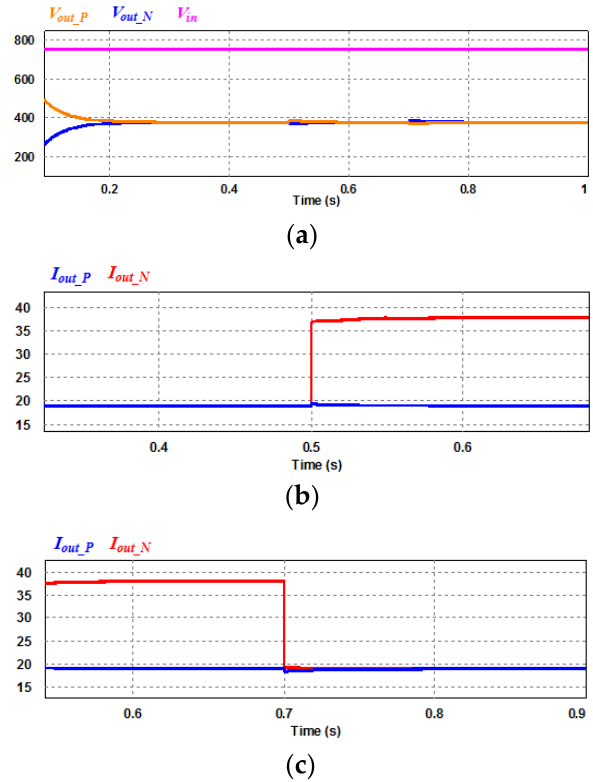
Figure 8. Simulation waveforms under load variation conditions: ( a ) Waveforms of input and output DC bus voltages during the whole simulation time; ( b ) waveforms of load currents at unbalanced load (increased load), ( c ) waveforms of load currents at unbalanced load (decreased load). Figure 9a,b are respectively waveforms of I L , which is the total inductor current of the CI, and Figure 9c,d are respectively current waveforms under the balanced load condition and unbalanced load condition. As a result of the simulation, the validity of constant voltage control of the bipolar voltage buses with the proposed VB is verified.